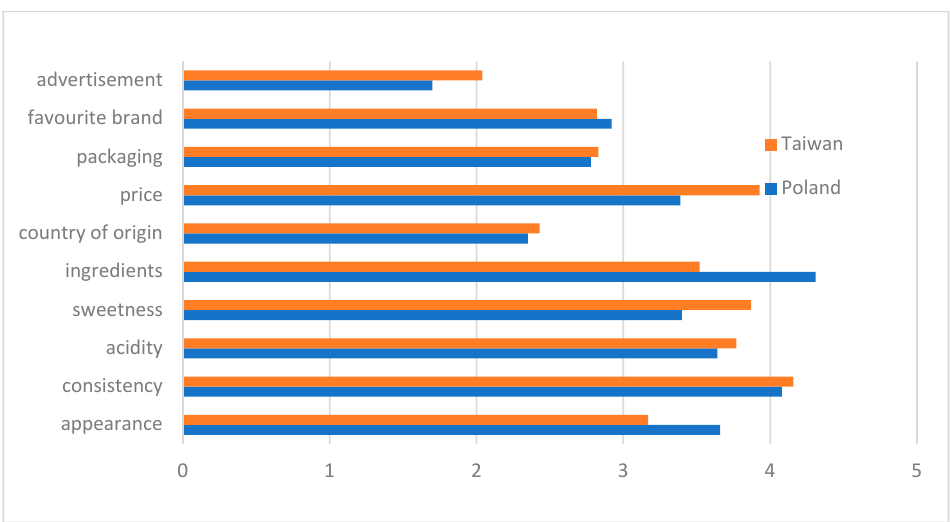
Figure 2. Characteristics of yoghurt influencing the decision to purchase it (1–5 scale: 1—least important, 5—most important).